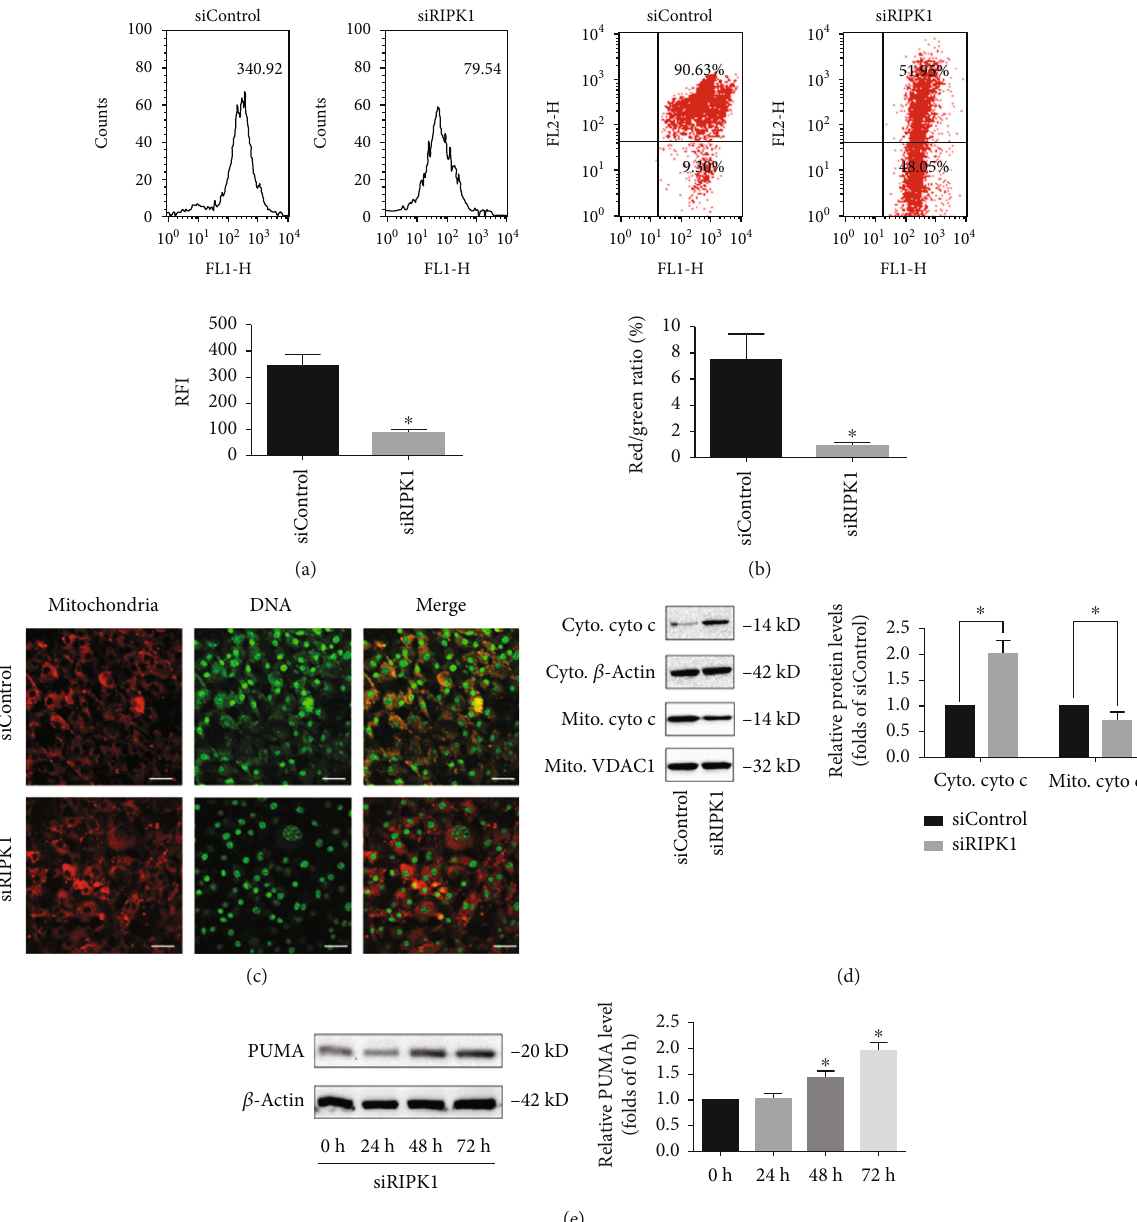
Figure 3: E ff ect of RIPK1 on mitochondrial homeostasis of bone marrow MSCs. (a) After 72h transfection with siRNA in bone marrow MSCs, the opening of mPTP was analyzed by the fl ow cytometer using mPTP Assay Kit. Representative graphs illustrated the increase of mPTP opening after knockdown of RIPK1. The quantitative mPTP in bone marrow MSCs was demonstrated by RFI. Data are expressed as the means ± SD from three independent experiments ( ∗ p < 0 : 05 , vs. siControl; n = 3 ). (b) Representative graphs illustrated the loss of MMP after knockdown of RIPK1. The quantitative MMP in bone marrow MSCs was demonstrated by red/green ratio. Data are presented as the means ± SD from three independent experiments ( ∗ p < 0 : 05 , vs. siControl; n = 3 ). (c) Representative confocal images were obtained in situ staining with MitoTracker (mitochondria, red) and PicoGreen (DNA, green). Knockdown of RIPK1 promotes mitochondrial DNA release into the cytoplasm ( scale bar = 50 μ m). (d) Representative western blots showing the release of cytochrome c. Histogram analysis showing the relative protein levels of cytochrome c. Data are presented as the means ± SD from three independent experiments ( ∗ p < 0 : 05 , vs. siControl; n = 3 ). (e) Representative western blots of the expression of PUMA. Histogram analysis showing the relative protein levels of PUMA. Data are presented as the means ± SD from three independent experiments ( ∗ p < 0 : 05 , vs. siControl; n = 3